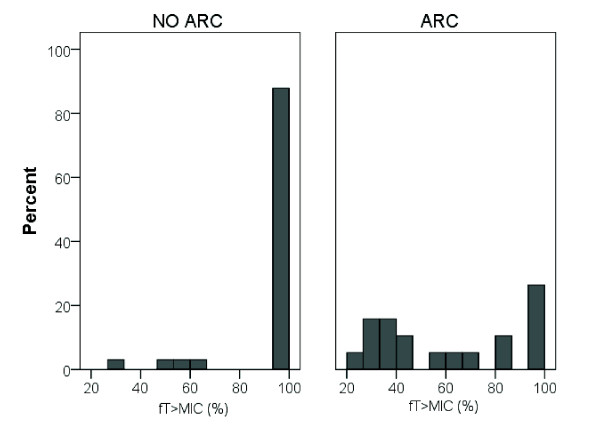
Histogram % fT>MIC for patients with and without ARC.